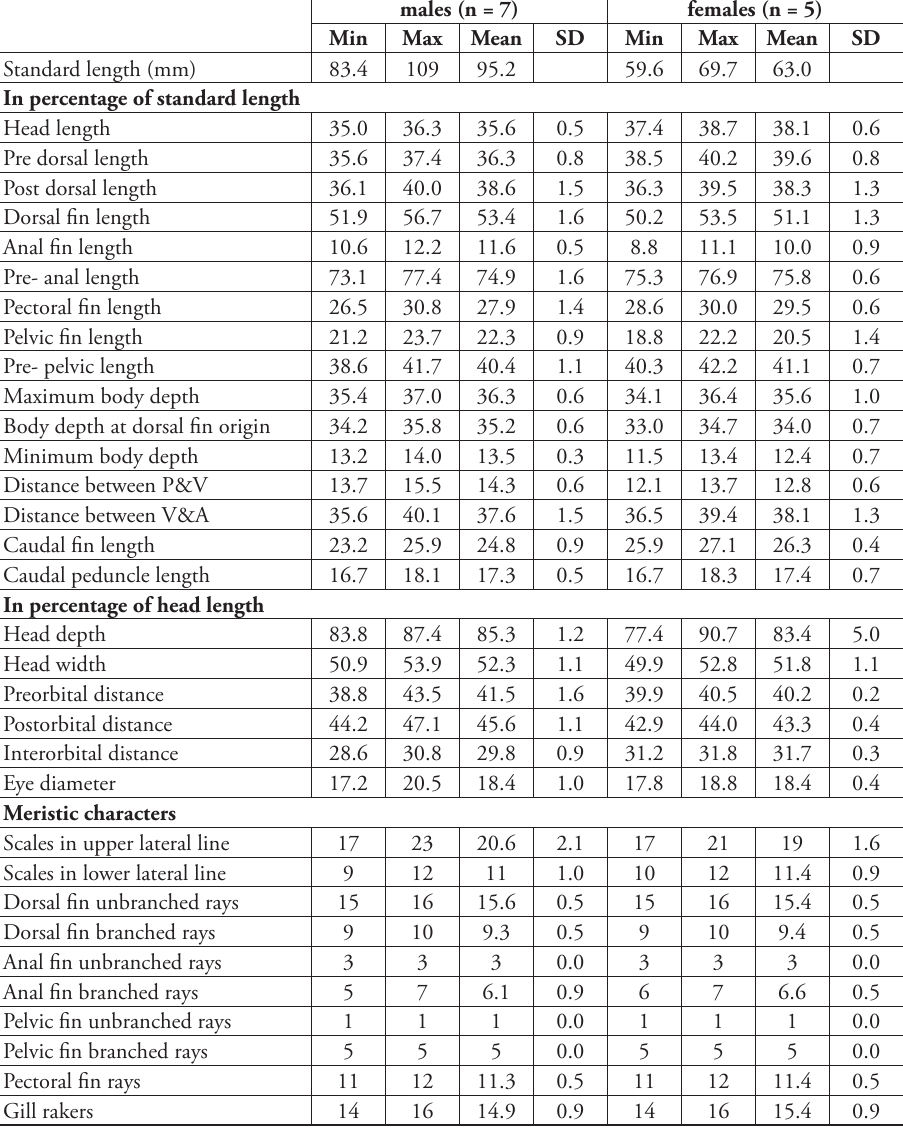
Table 2. Morphometric and meristic data of Iranocichla sp. from Kol River drainage (Gode-Gaz stream) (ZM-CBSU34-40, H1547-H1551; n = 12). males (n =